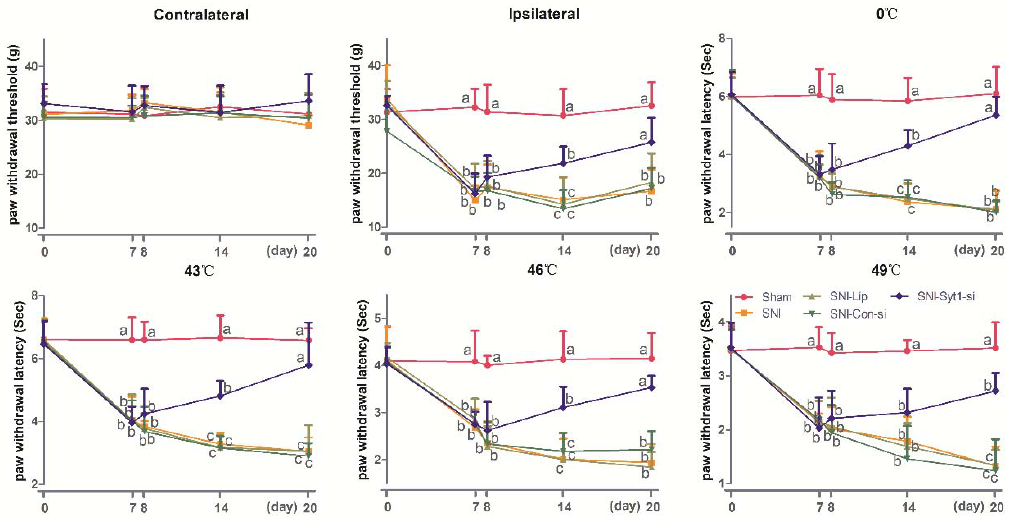
Figure 3. The e ff ect of Syt-1 siRNA on PWTs and PWLs (Mean ± SD, n = 6). Rats in SNI-Lip, SNI-Con-si Figure 3. The effect of Syt ‐ 1 siRNA on PWTs and PWLs (Mean ± SD, n = 6). Rats in SNI ‐ Lip, SNI ‐ Con ‐ and SNI-Syt1-si groups were intrathecally injected with 15 µ L lipofectamine, 10 µ L lipofectamine + 5 µ L si and SNI ‐ Syt1 ‐ si groups were intrathecally injected with 15 μ L lipofectamine, 10 μ L lipofectamine + control siRNA and 10 µ L lipofectamine + 5 µ L Syt-1 siRNA, respectively. Syt-1 siRNA induced increased 5 μ L control siRNA and 10 μ L lipofectamine + 5 μ L Syt ‐ 1 siRNA, respectively. Syt ‐ 1 siRNA induced ipsilateral PWTs and PWLs (0, 43, and 46 ◦ C) at day 14 and 20 compared with SNI group. Values with increased ipsilateral PWTs and PWLs (0, 43, and 46 °C) at day 14 and 20 compared with SNI group. di ff erent letters (a, b and c) at the same day show di ff erent ( p < 0.05); two-way ANOVA followed by Values with different letters (a, b and c) at the same day show different ( p < 0.05); two ‐ way ANOVA Bonferroni followed by Bonferroni test.